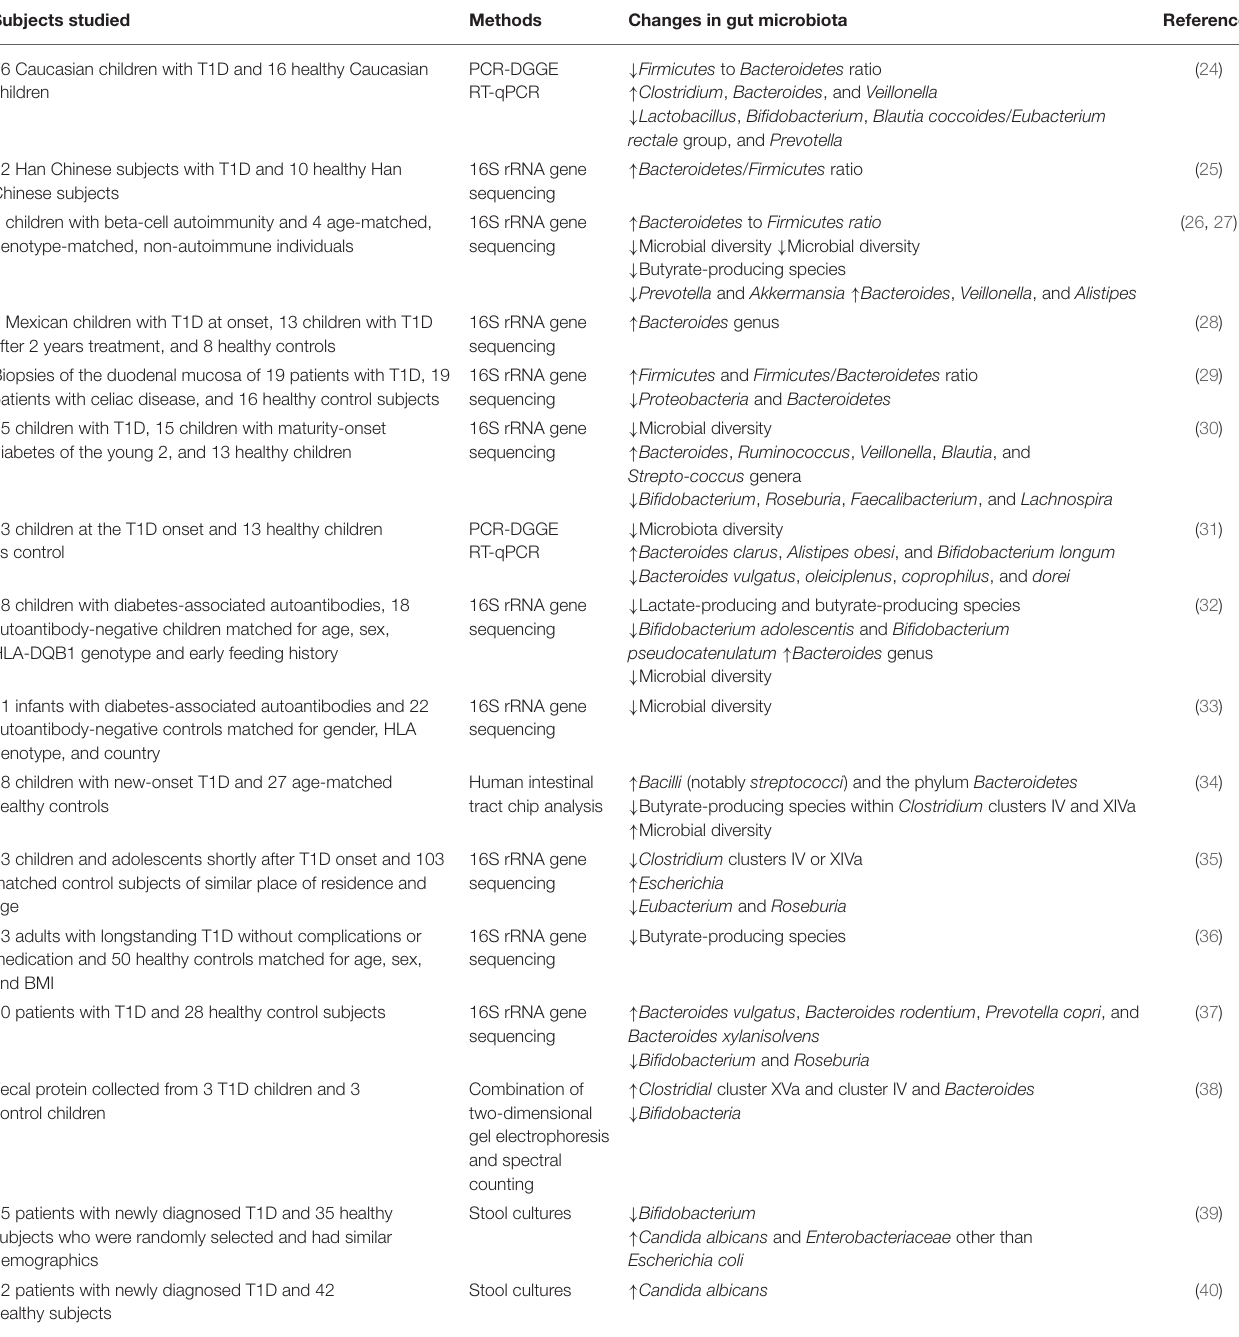
TABLE 1 | Gut microbiota changes in preclinical and clinical type 1 diabetes